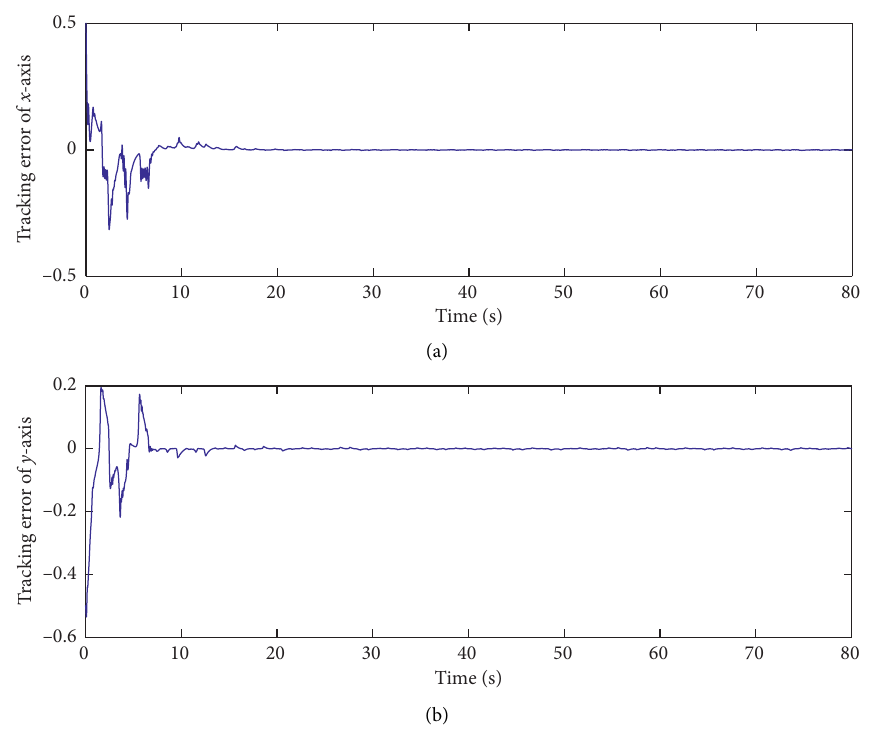
Figure 6: Tracking error using conventional fast TSM surface.